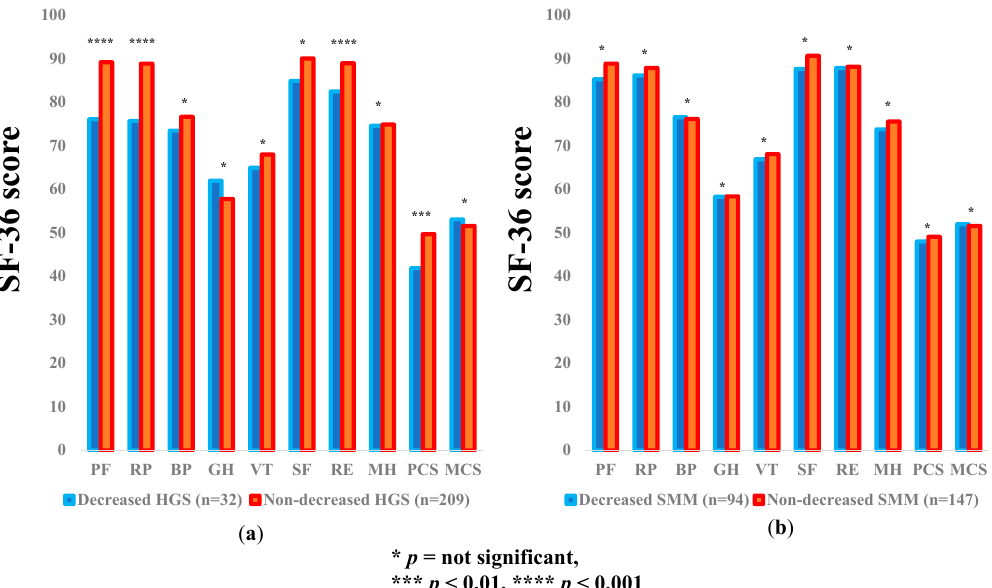
Figure 3. The SF-36 scores across 10 items in the decreased and non-decreased HGS groups ( a ), and the decreased and non-decreased SMM groups ( b ) in non-LC patients ( n = 241). The average scores in each item of the SF-36 were